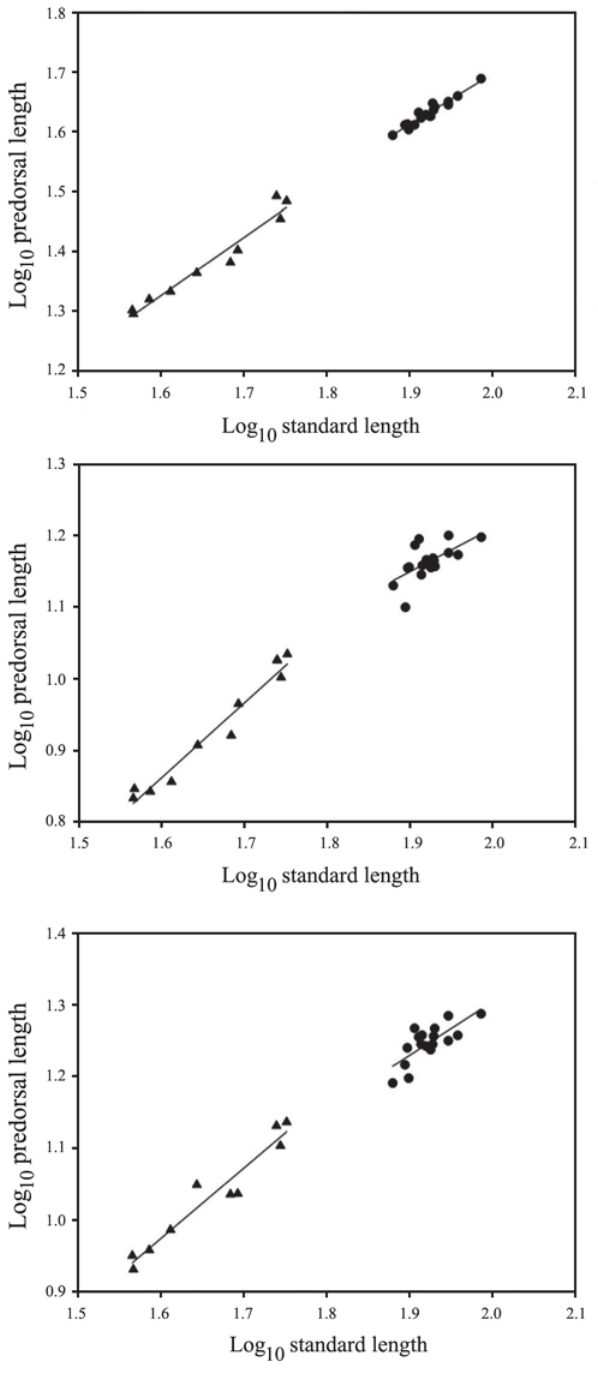
Fig. 6. Scatter plot and regresión line of pelvic-fin length, pectoral-fin length, and predorsal length on standard length in A . erythropterus . Triangles = juveniles; circles = adults.